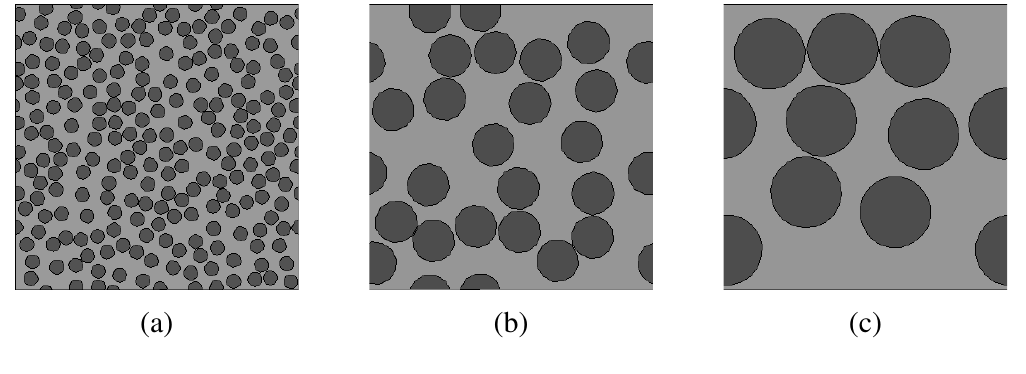
Figure 9. Statistically isotropic distribution of circular cylinders with variable radius of their cross-section.